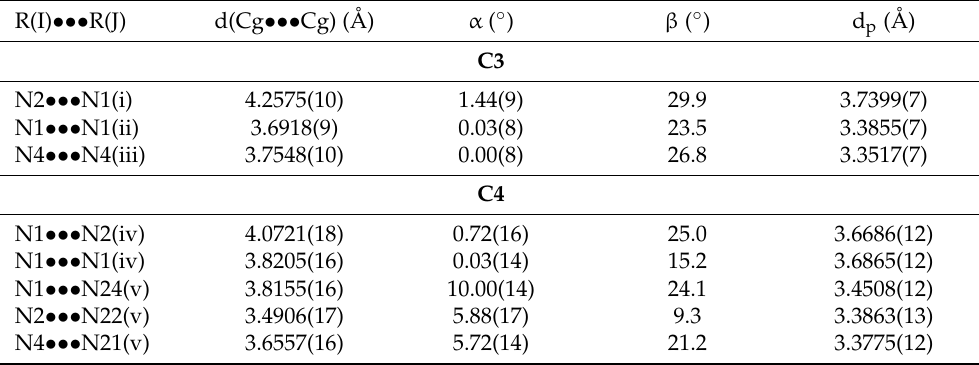
Table 6. Stacking interactions in the structures of C3 and C4 . Each ring is indicated by one atom, which belongs solely to this ring. The α is a dihedral angle between planes I and J, β is an angle between Cg(I)–Cg(J) vector and normal to plane I, d p is a perpendicular distance of Cg(I) on ring J plane.